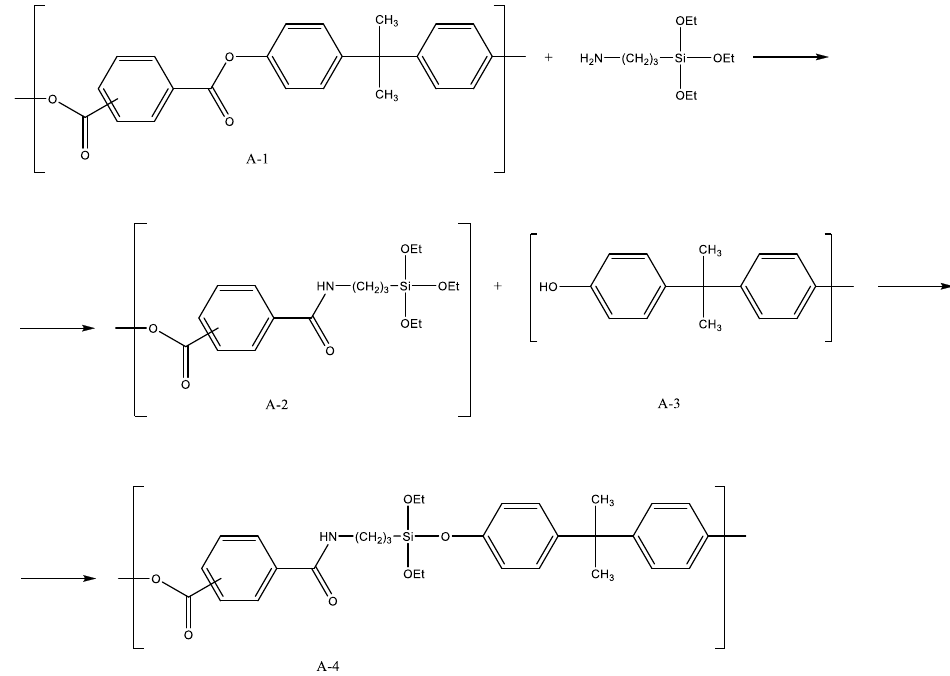
Figure 1. Scheme for the synthesis of poly(acrylate-siloxane). Adopted from Ref. [22].